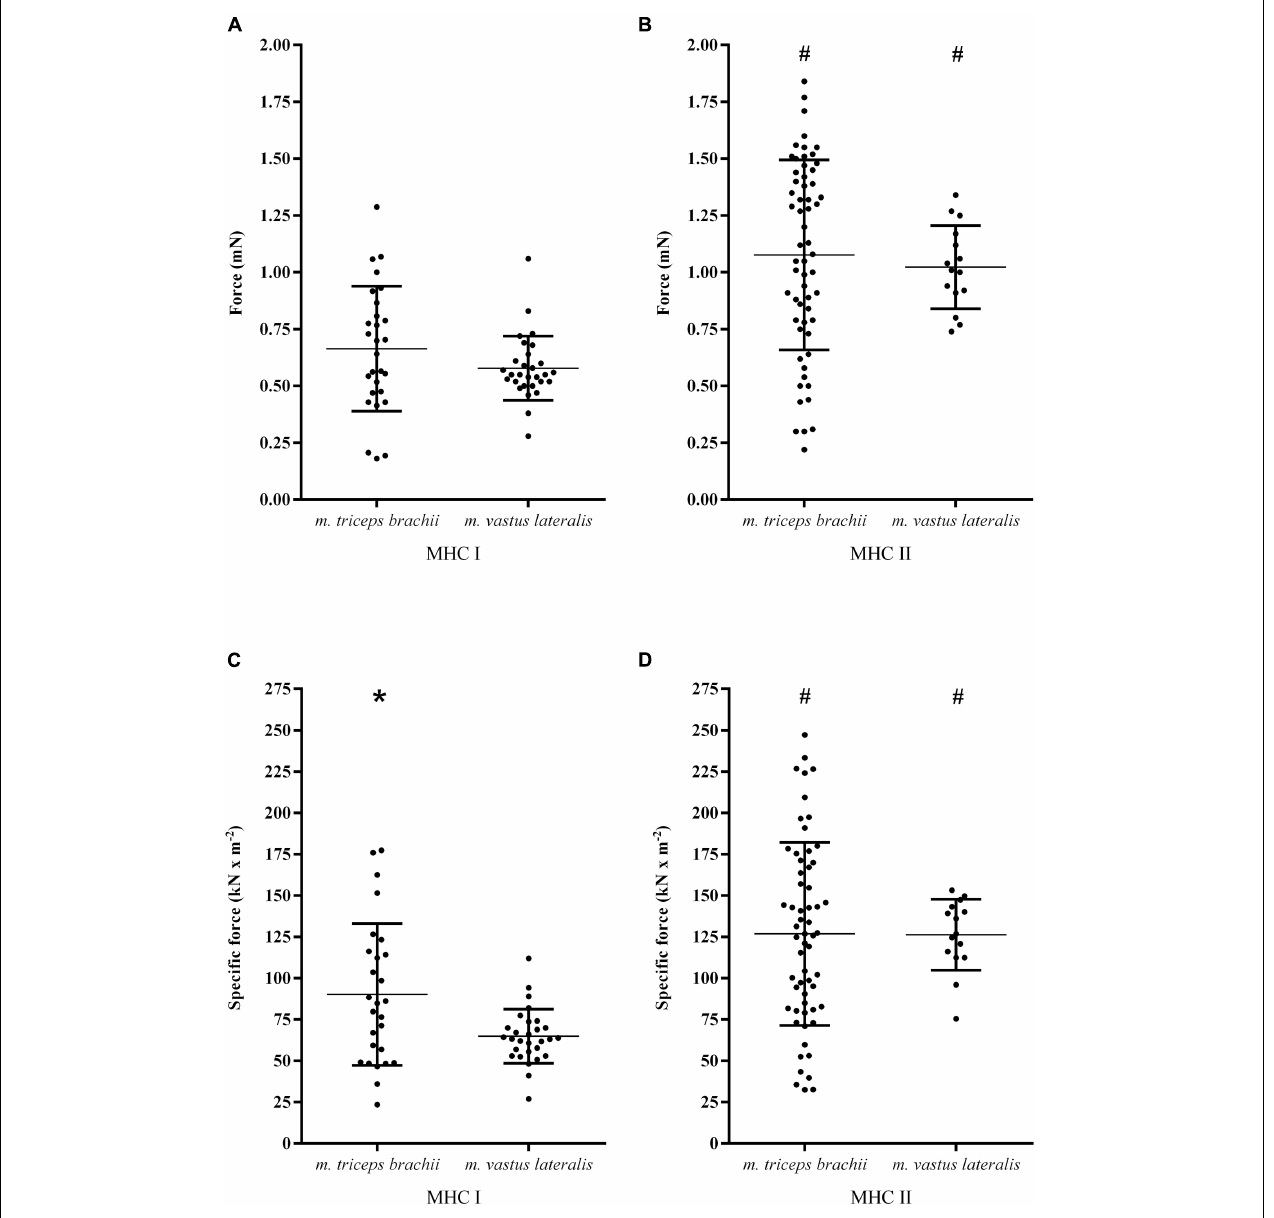
FIGURE 1 | The maximal Ca 2 + -activated force and specific force (i.e., force per CSA) in MHC I (A,C) and MHC II fibers (B,D) isolated from the m. triceps brachii and m. vastus lateralis of eight highly trained cross-country skiers. The dots represent values for individual fibers, the horizontal lines the mean value and vertical lines the standard deviations. MHC I fibers: n = 28 in m. triceps brachii ; n = 29 in m. vastus lateralis . MHC II fibers: n = 60 in m. triceps brachii ; n = 15 in m. vastus lateralis . There were significant MHC × limb interactions for both maximal Ca 2 + activated force ( P < 0.0001) and specific force ( P < 0.0001). # Significantly different from MHC I fibers from the same muscle ( P = 0.002); *Significantly different from the same MHC isoform of m. vastus lateralis ( P = 0.003).